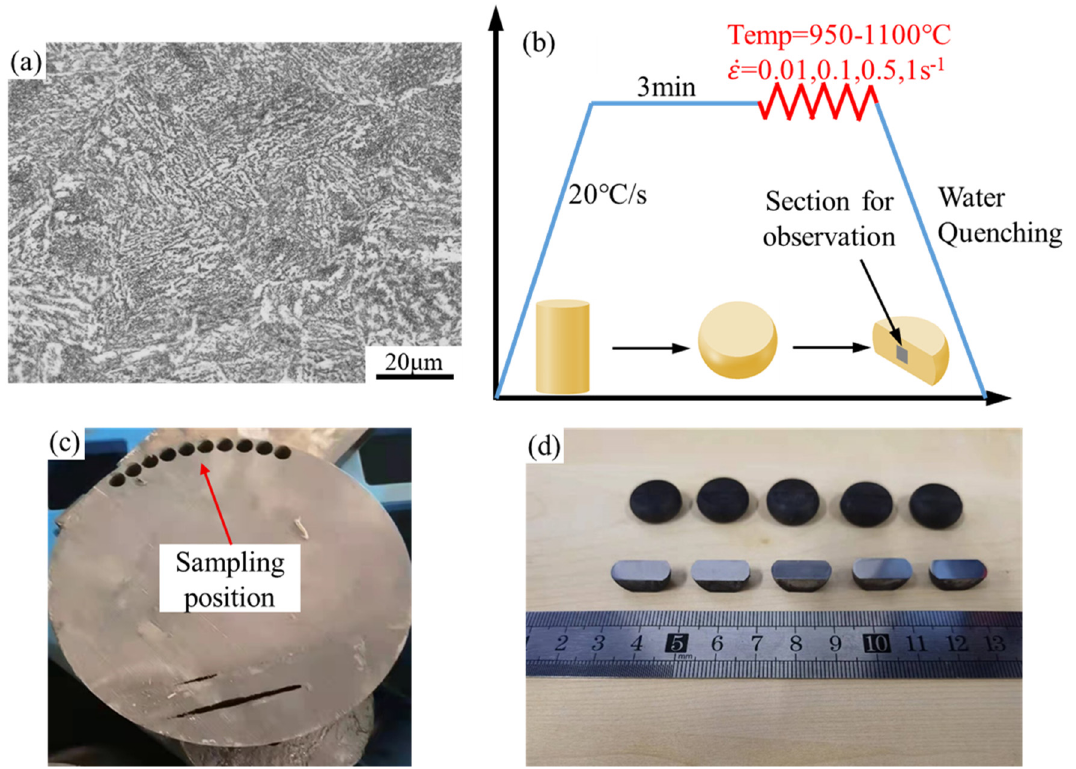
Figure 1. ( a ) Microstructure of the as-received specimen; ( b ) Experimental procedure of compression tests; ( c ) Sampling position; ( d ) Hot compressed specimens and polished section. Table 1. Chemical composition of the 25CrMo4 steel.